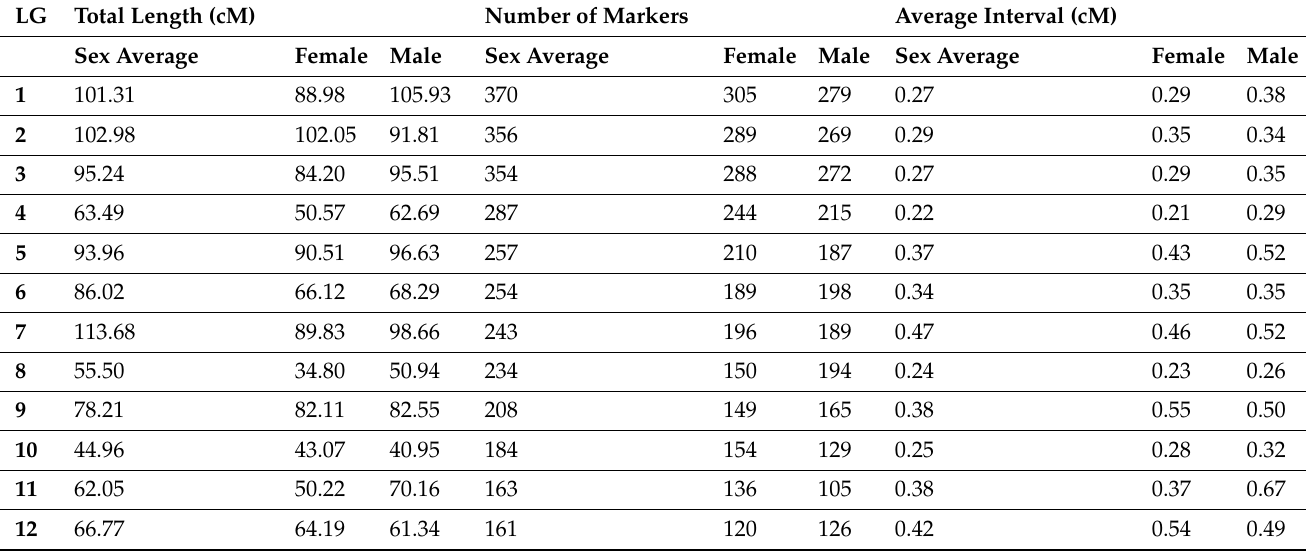
Table 1. Statistical summary of Hapalochlaena maculosa sex averaged, paternal and maternal linkage maps. Linkage groups